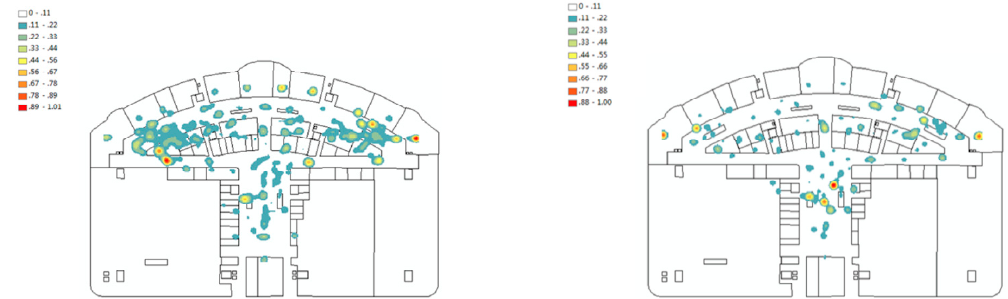
Figure 16. Record of October 1st and September 26th.